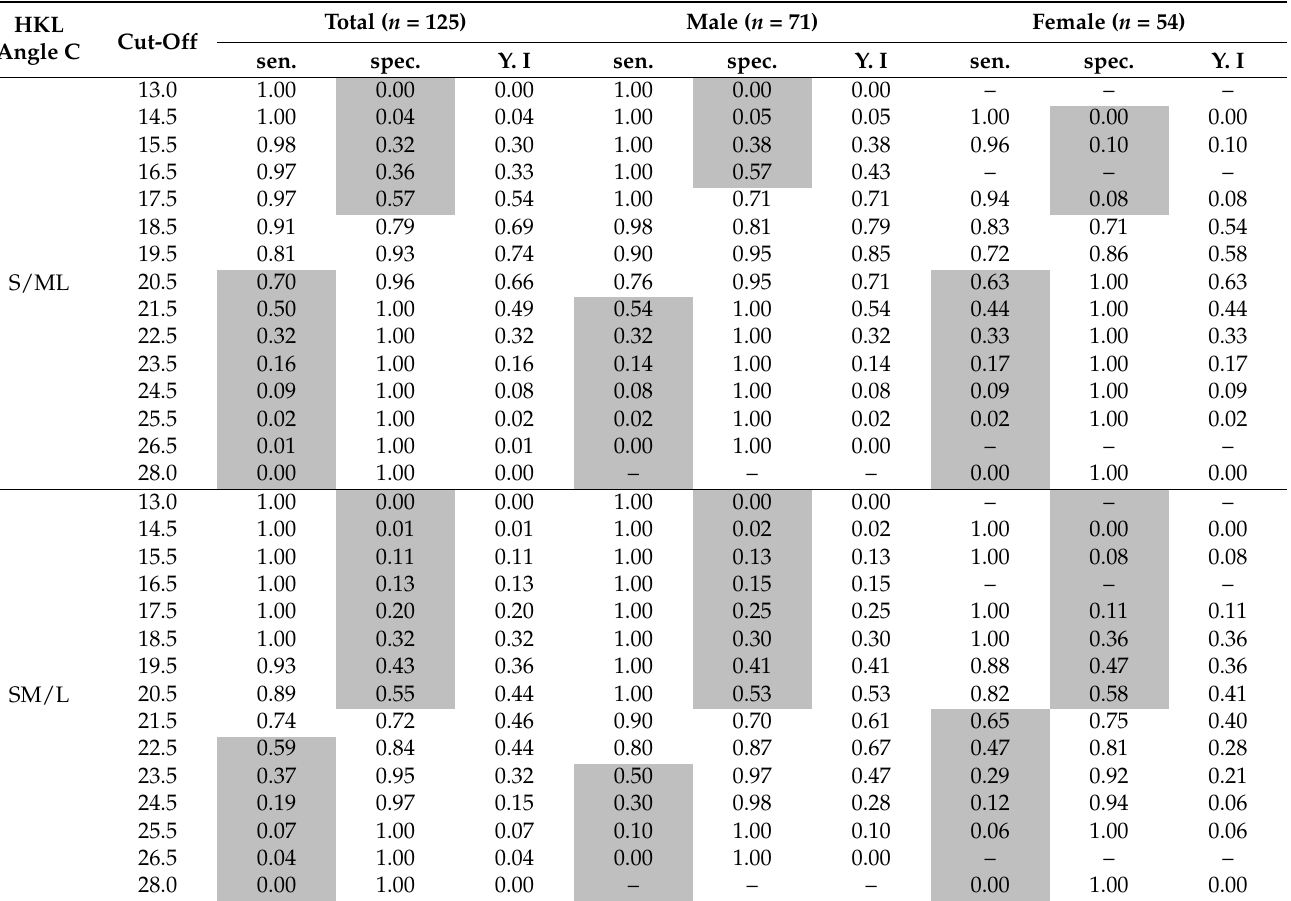
Figure 2. AUCs and HKL angles discriminating small (<42 ◦ ) or large (>51 ◦ ) PIs. Table 1. The results of sensitivity, specificity, and Youden index of the HKL angle